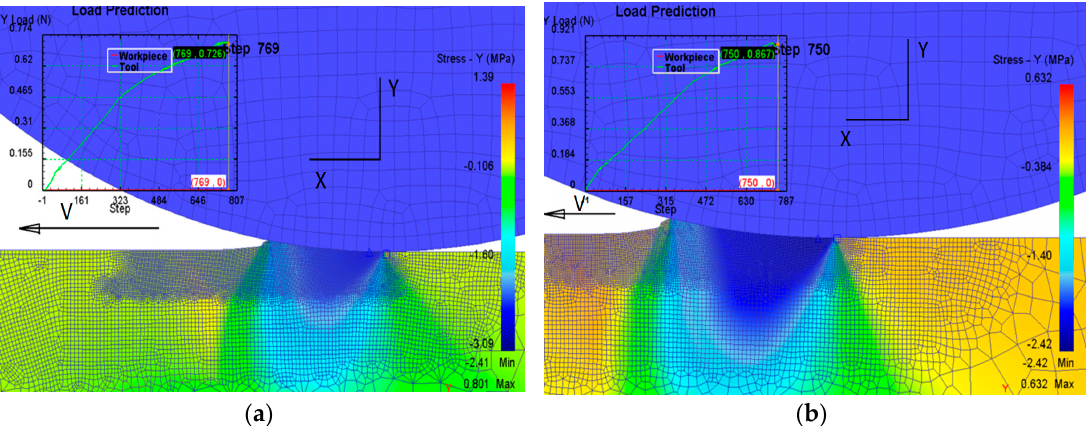
Figure 7. Dependence of the relative pressure by Equation (35) (yield stress = 1 MPa) during finite elements simulation of wide burnishing by indenter R = 2 mm at ( a ) t = 0.004 mm; ( b ) t = 0.008 mm.